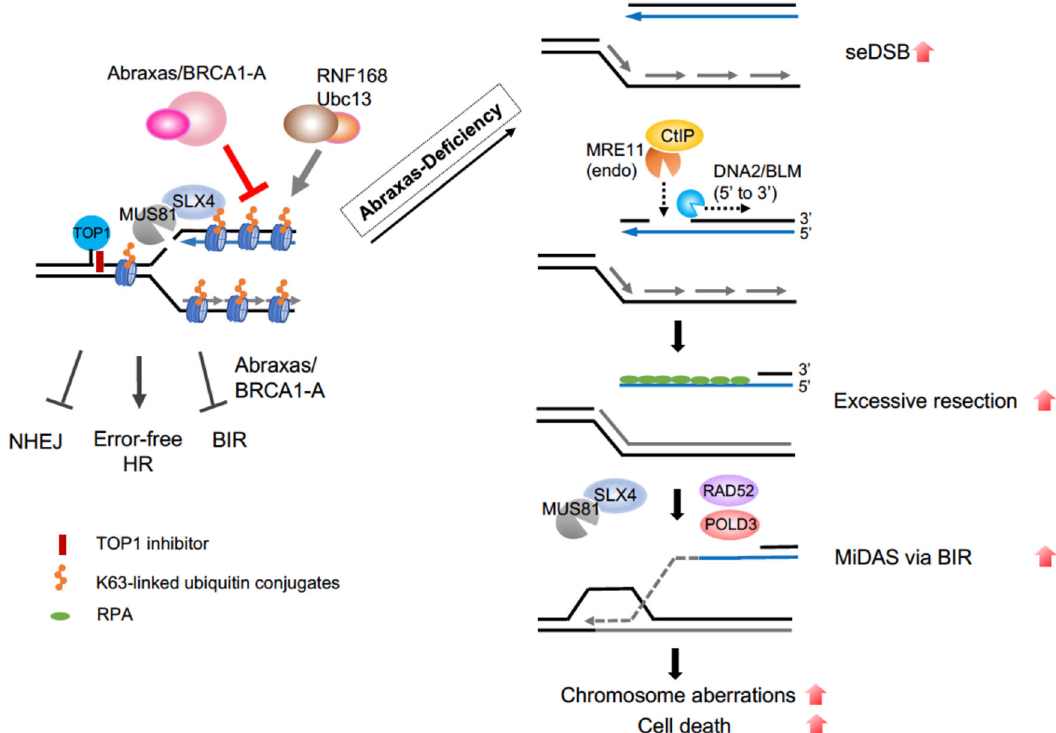
Fig. 8 A proposed model for the role of Abraxas/BRCA1-A complex. Abraxas/BRCA1-A complex inhibits DNA end resection and limits BIR by restricting SLX4/MUS81 chromatin loading through counteracting K63-linked ubiquitin modi fi cation catalyzed by RNF168/Ubc13 in response to CPT. In the absence of Abraxas, increased K63-linked ubiquitin conjugation leads to SLX4/MUS81 overloading on chromatin, generating increased seDSBs, which are further processed by MRE11 endonucleases, CTIP and DNA2/BLM, forming an extensive length of ssDNA. Uncontrolled MUS81 loading and excessive end resection also involve RAD52- and POLD3-dependent BIR that results in increased mitotic DNA synthesis, extensive chromosome aberrations, and cell lethality in Abraxas-de fi cient